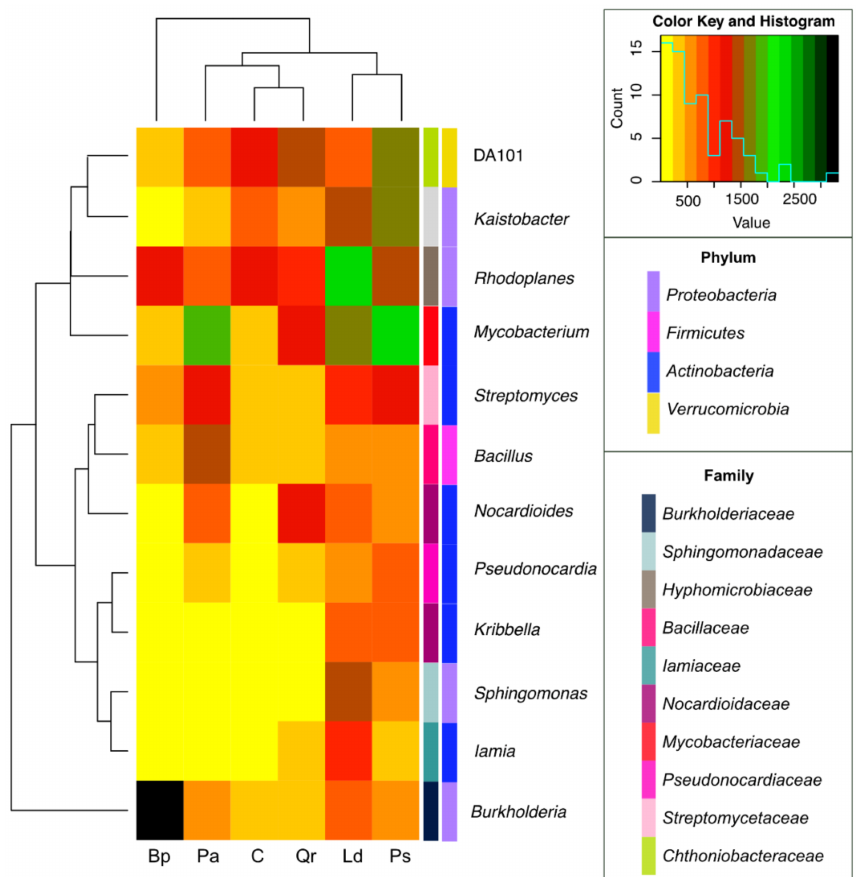
Figure 8. A heat map presenting associations between bacterial genera in the forest soils tested with the difference between ratios ≥ 1%. The smallest amounts of bacterial OTU are shown in yellow, while the largest amounts of OTU are shown in black. The blue line shown in the “color key and histogram” shows how many times each data point appears in the matrix used in the heat map.C—non-afforested land, Pa— Picea abies L., Ps— Pinus sylvestris L., Ld— Larix decidua M., Qr— Quercus robur L., and Bp— Betula pendula L. Table 1. The Shannon–Weaver (H’) indexes of microbial diversity (greater than or equal to 1%). Taxa C Pa